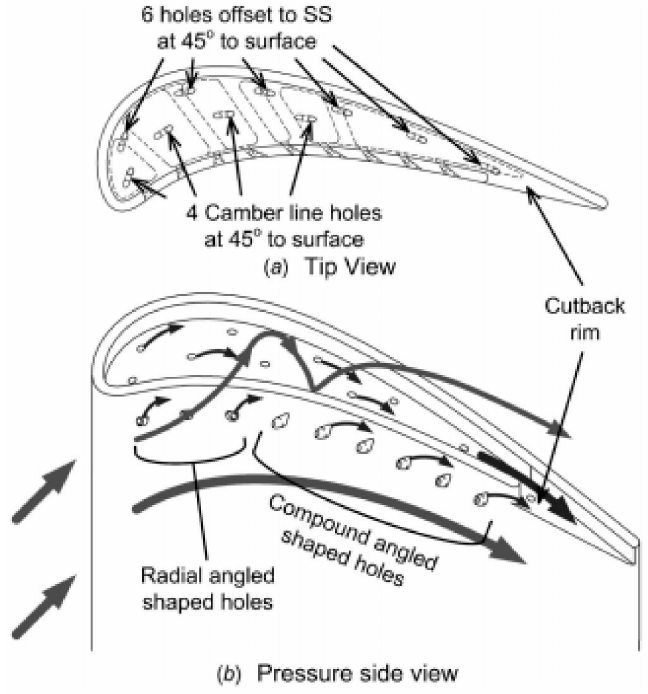
Figure 4. Turbine blade tip cooling [4]. Reprint with permission from ASME (order number 1084744).